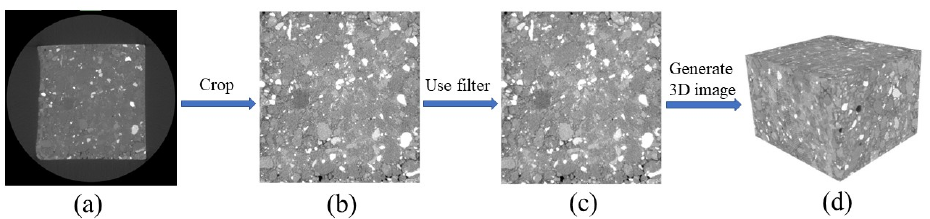
Figure 3. Raw image processing: ( a ) original image; ( b ) cropped image; ( c ) image after adding filter; ( d ) 3D image.